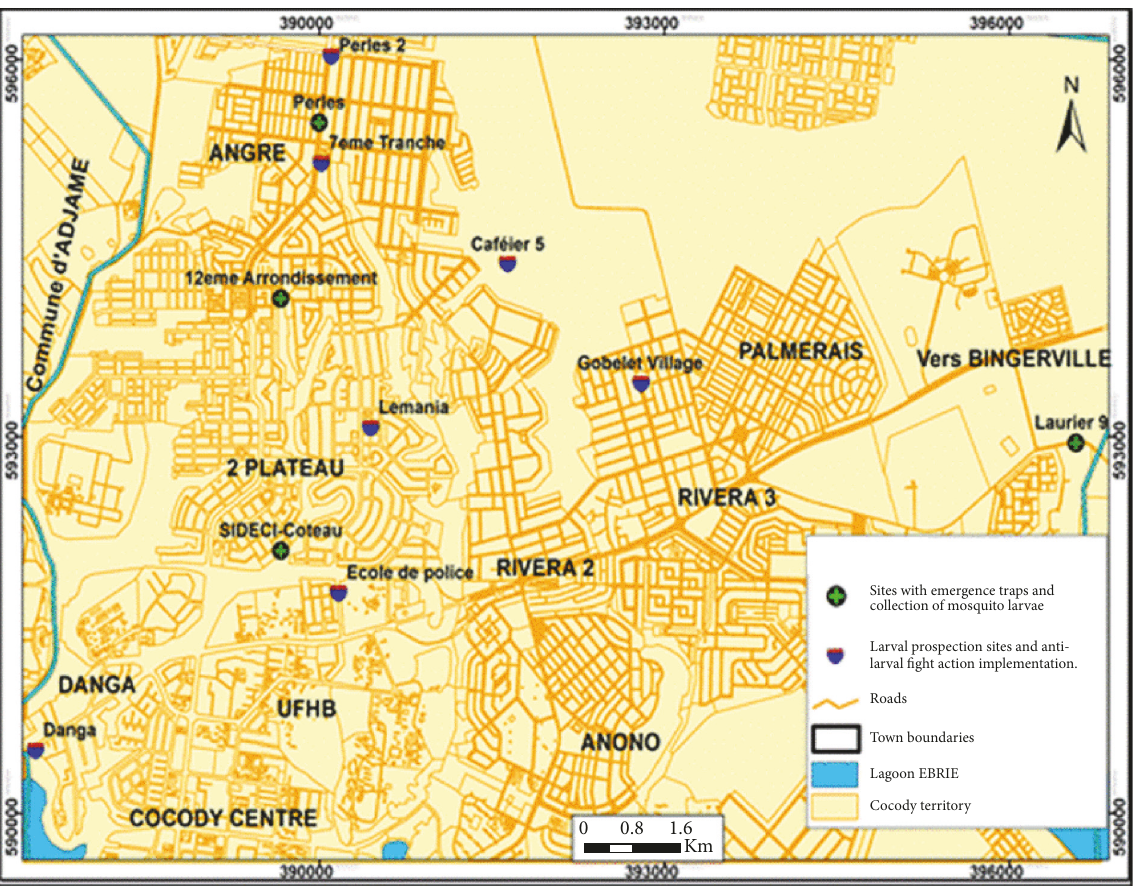
Figure 1: Location of the city of Cocody showing study